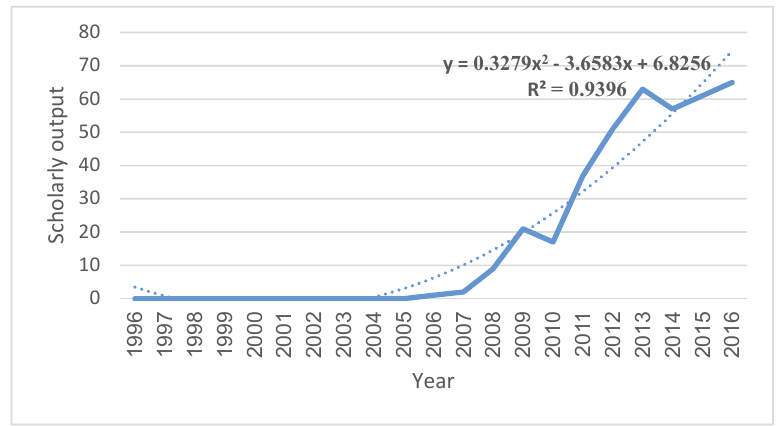
Fig. 2. Trend of publications on “Metamodel and simulation optimization” impact (data from 1996 to date)